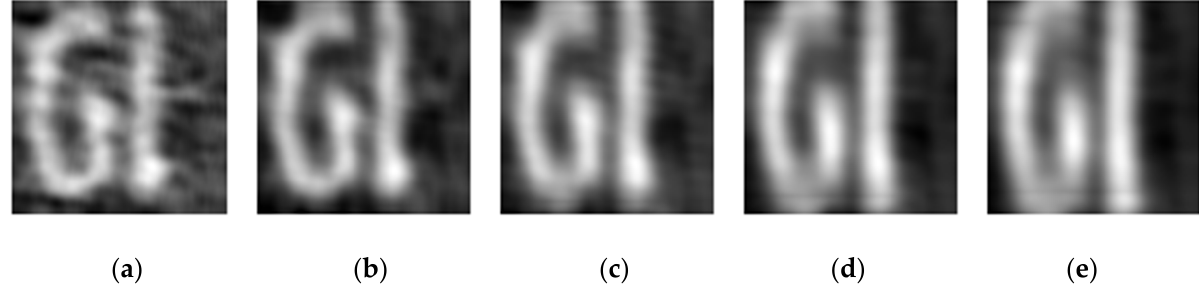
Figure 7. Reconstructed images of the SC with the Hessian matrix in different standard deviations. ( a ) σ = 1 ; ( b ) σ = 2 ; ( c ) σ = 3 ; ( d ) σ = 4 ; ( e ) σ = 5 .